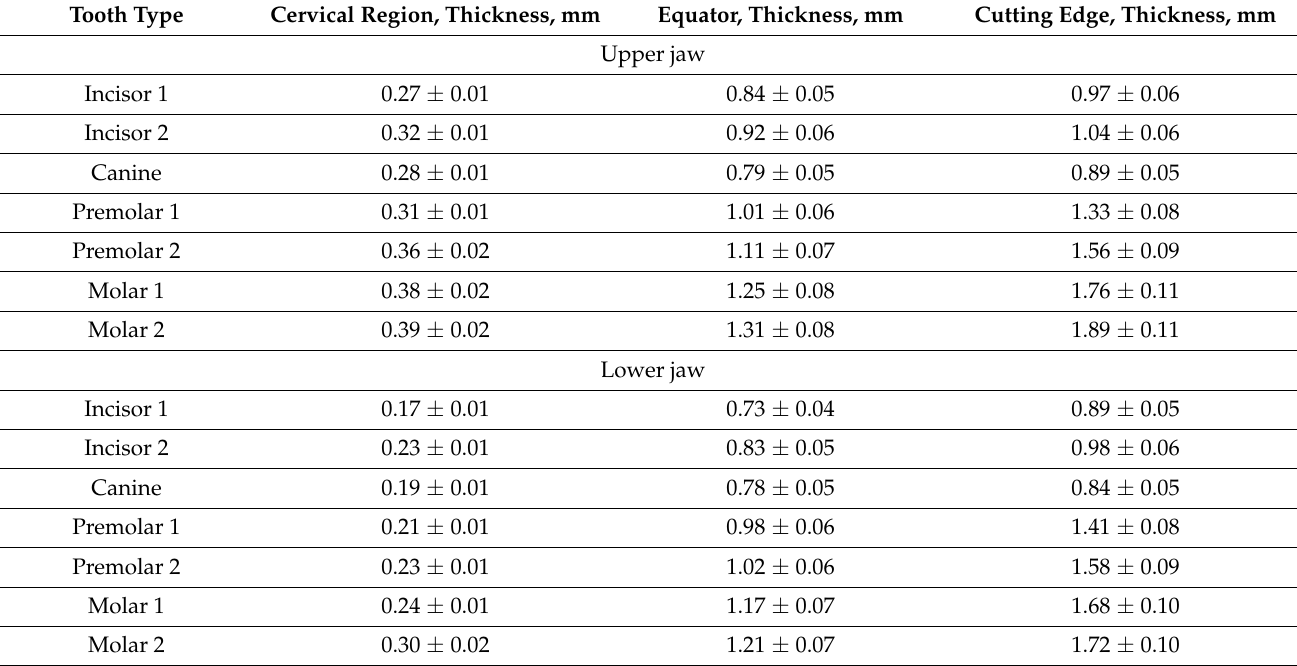
independent methods (computer tomography (Table 1) and electron microscopy (Table 2)) were used to determine the enamel thickness values of different teeth in different areas (cutting edge, equator, cervical region) on a large sample of patients. Table 1. Enamel thickness in the cervical region, equator, and the cutting edge. Multispiral computed tomography (MSCT) method [24].